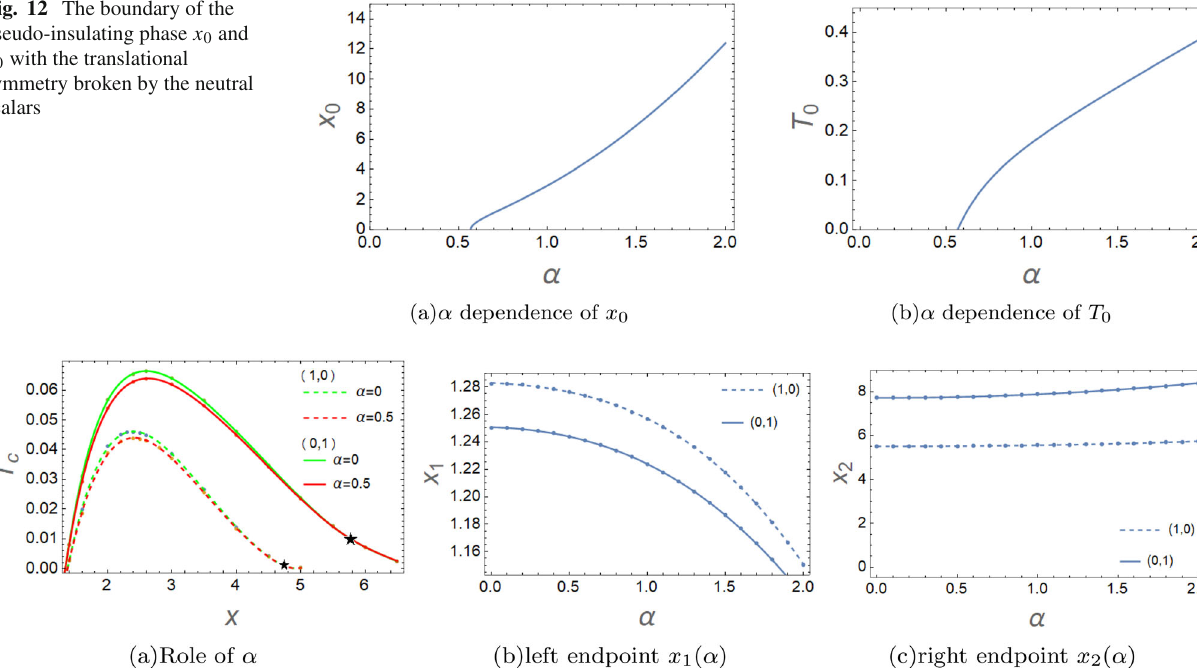
x 2 of the superconducting region. We fix a = 10 , b = 4 / 3 , c = 14 / 3 and choose different α . The dashed line represents ( 1 , 0 ) , and the solid line represents ( 0 , 1